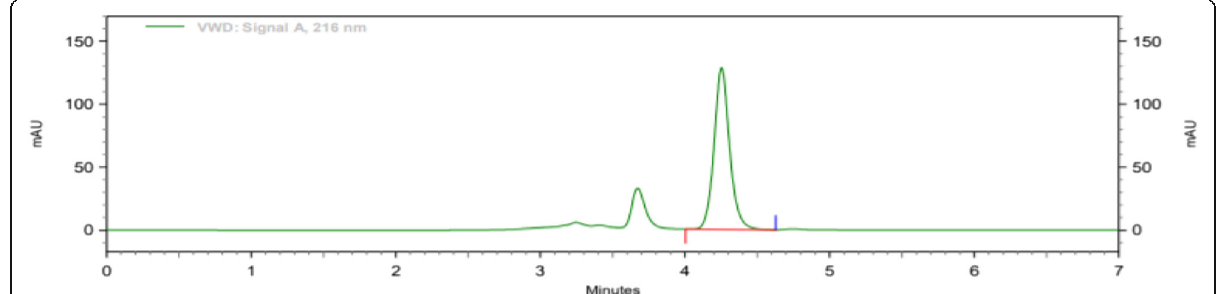
Fig. 7 Typical chromatogram of unfiltered sample